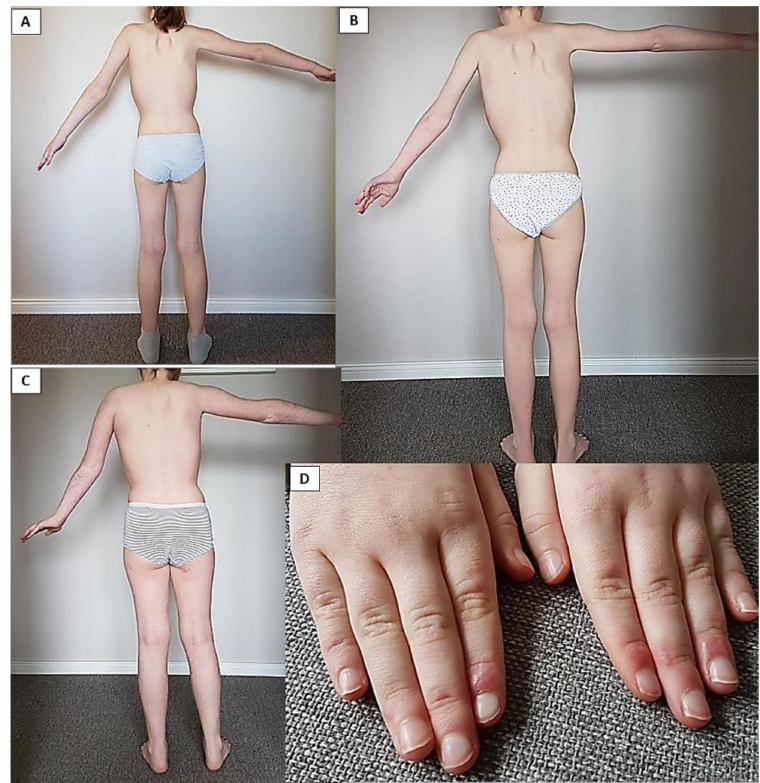
Figure 2. Patient 1 presenting asymmetrical weakness in her upper extremities. The patient presents the highest active elevation of her arms: ( A ): 3 months after methlyprednisolone intravenous therapy in combination with oral steroids and methotrexate; ( B ): 20-month follow up (rituximab, intravenous immunoglobulins, and methotrexate). The strength in her right arm was better compared to her left arm. Asymmetrical weakness persisted at the 2 years and 7 months follow up ( C ), and she developed skin lesions for the first time (periungual exanthema) ( D ).